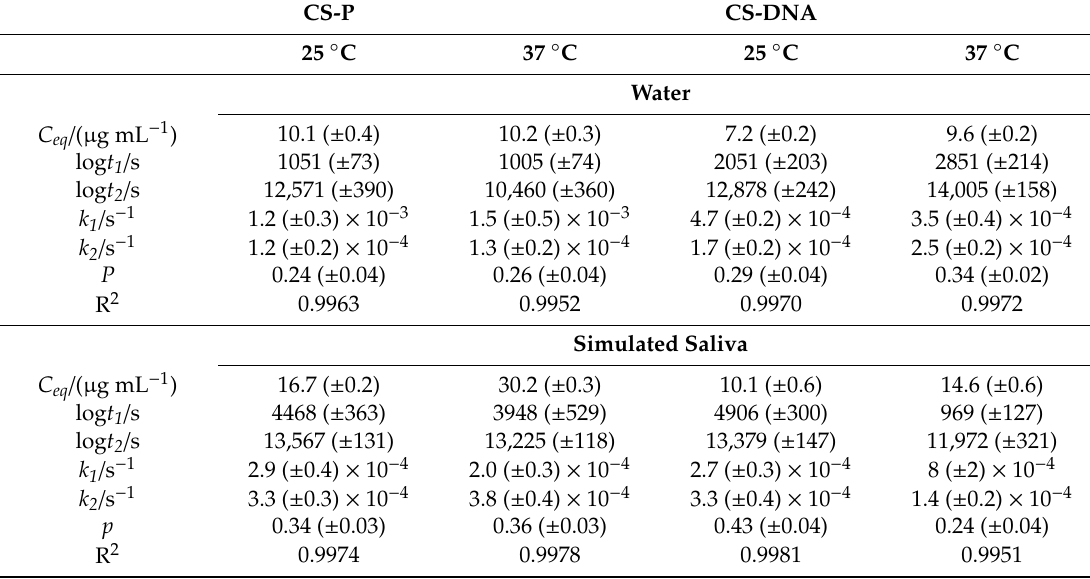
Table 2. Fitting parameters of Equation (1) to experimental release data of GP loaded into CS-P and CS-DNA gels to simulated saliva, at 25 ◦ C and 37 ◦